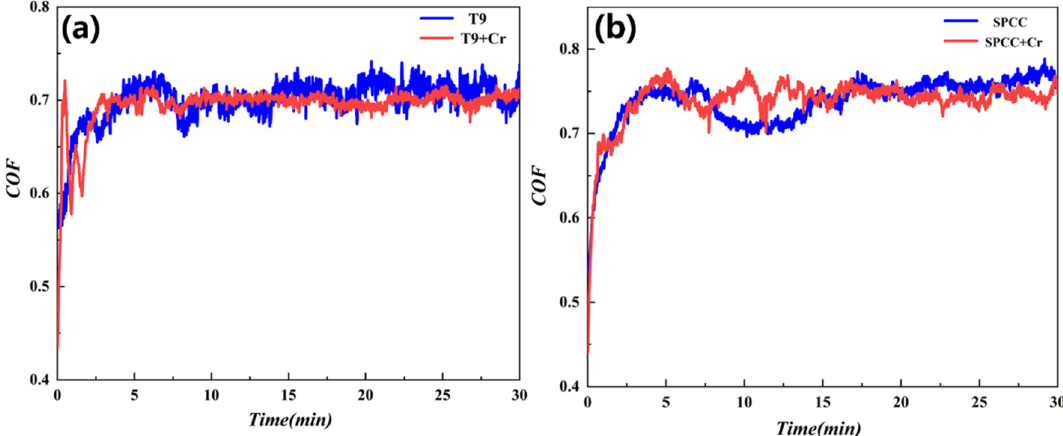
Figure 10. Variation curves of the friction coefficient: ( a ) T9 steel substrate and chromized T9 steel and ( b ) SPCC steel substrate and chromized SPCC steel. and ( b ) SPCC steel substrate and chromized SPCC